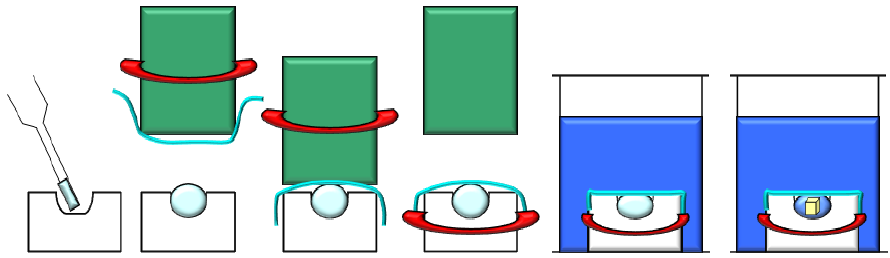
Figure 6. Microdialysis method. The droplet of protein solution is placed in a small button, which is covered with a dialysis membrane and closed with a thin elastic band. The button is immersed in the precipitant solution and the equilibration of precipitant molecules occurs through the membrane.